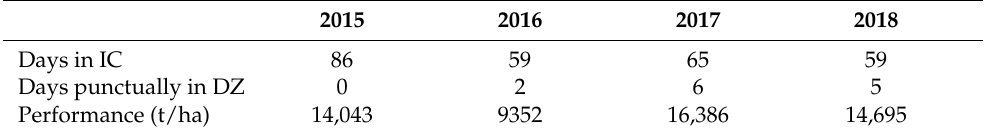
Table 6. Ratio of days in ideal conditions (IC), conditions in dangerous zone (DZ) together with the olive crop performance in Extremadura (Spain) in the analyzed period.